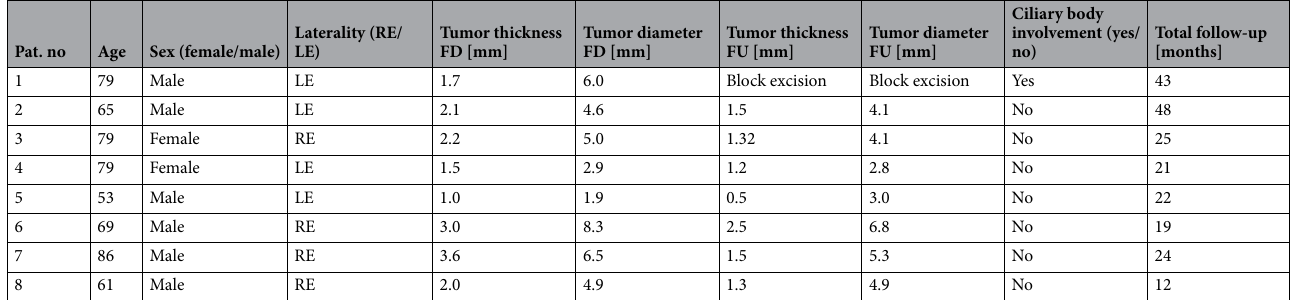
Table 1. Patient characteristics. FD first diagnosis, FU follow-up, RE right eye, LE = left